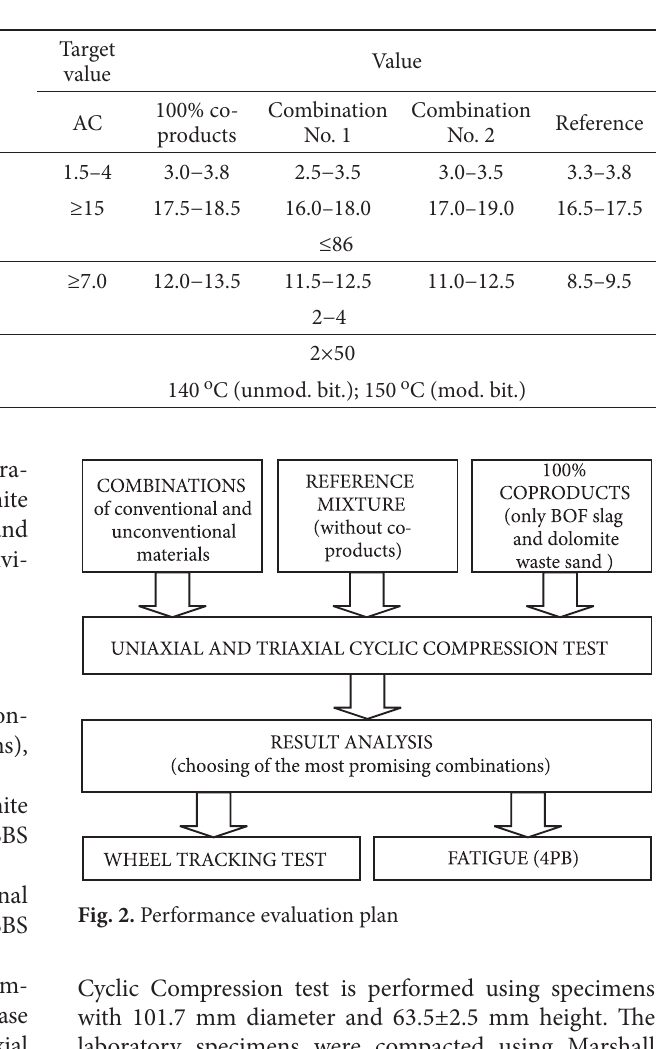
table 6. Principle properties of asphalt concrete mixes